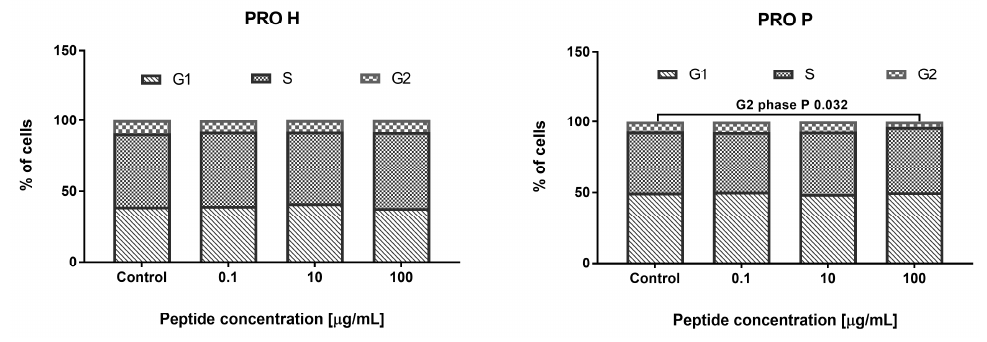
Figure 3. The effect of PRO H and PRO P on the cell cycle phases.